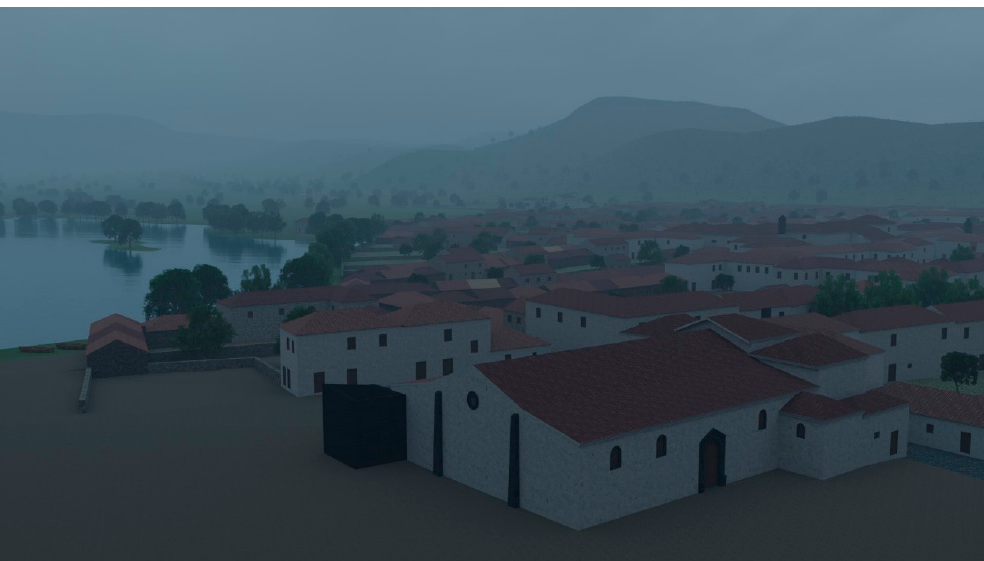
Figure 27. An image of the city under the weather conditions described by Torriani.